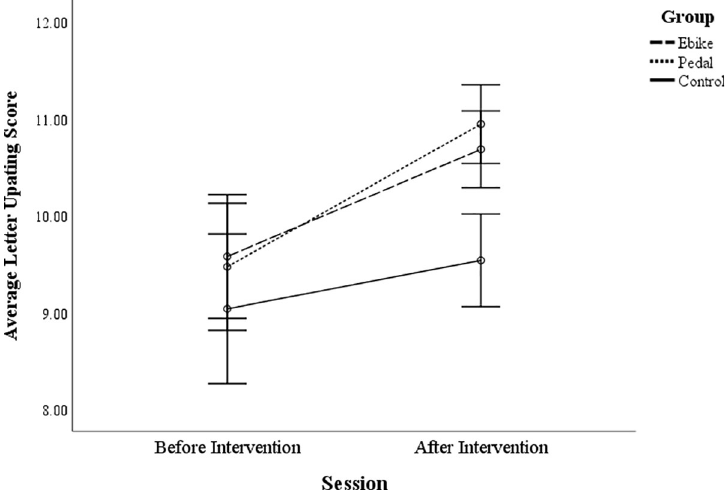
Fig 3. Letter updating score for non-cycling controls, pedal cyclists and E-bike cyclists before and after the intervention. Error bars are +/- 2